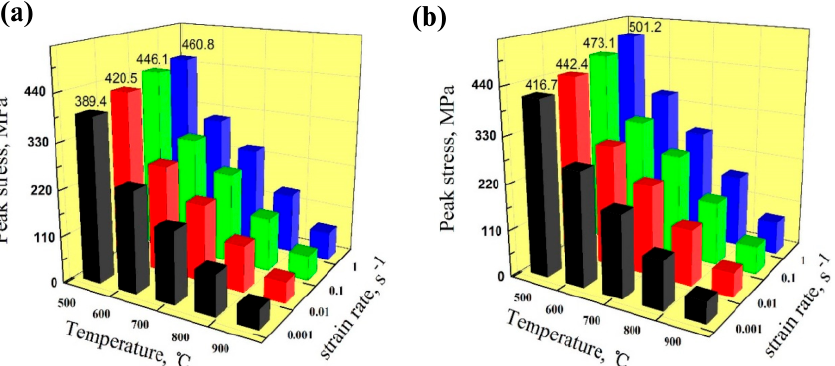
Figure 7. Peak stress of the Cu–Ni–Co–Si–Cr and Cu–Ni–Co–Si–Cr–Ce alloys deformed at different strain rates and temperatures: ( a ) Cu–Ni–Co–Si–Cr alloy; ( b ) Cu–Ni–Co–Si–Cr–Ce alloy [13]. Reprinted/adapted with permission from Ref. [13]. Copyright year 2020, MDPI AG.